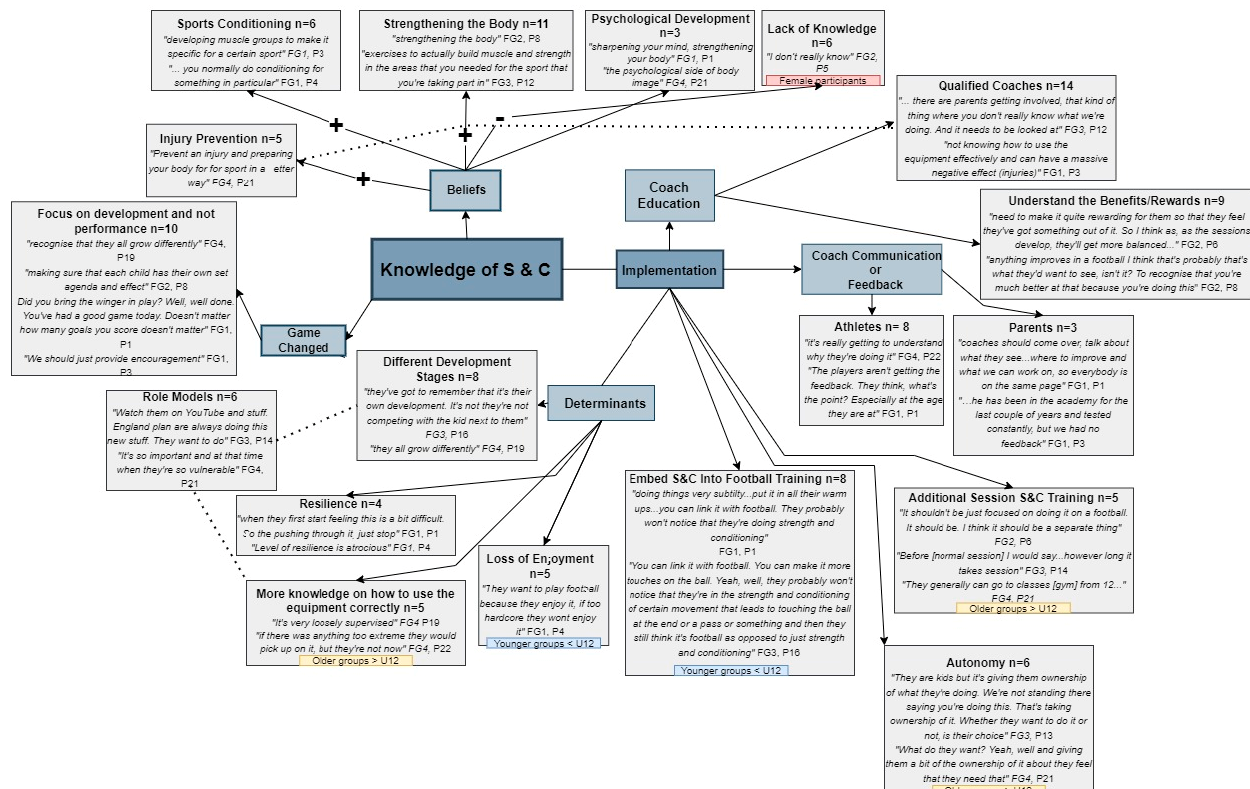
Figure 1. Key themes and sub-themes generated from the focus group discussions reflecting parental knowledge, beliefs and perceptions of strength and conditioning for children.